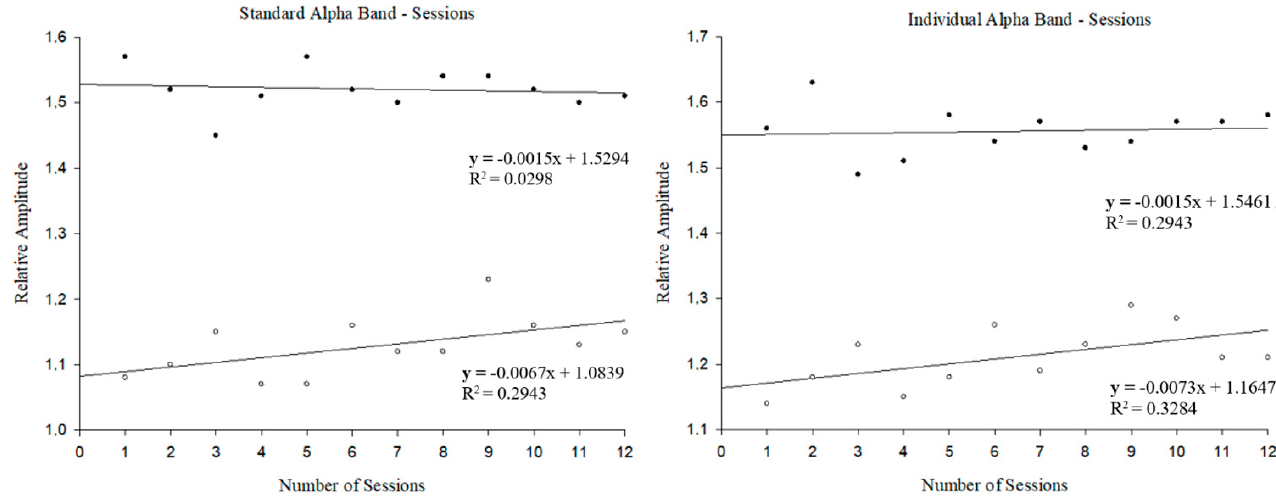
Figure 3. Differences between session 1 and 12 standard alpha band ( left image ) and individual standard alpha band ( right image ) for each protocol; filled dots represents the silent room group and empty dots represents the noisy room group.